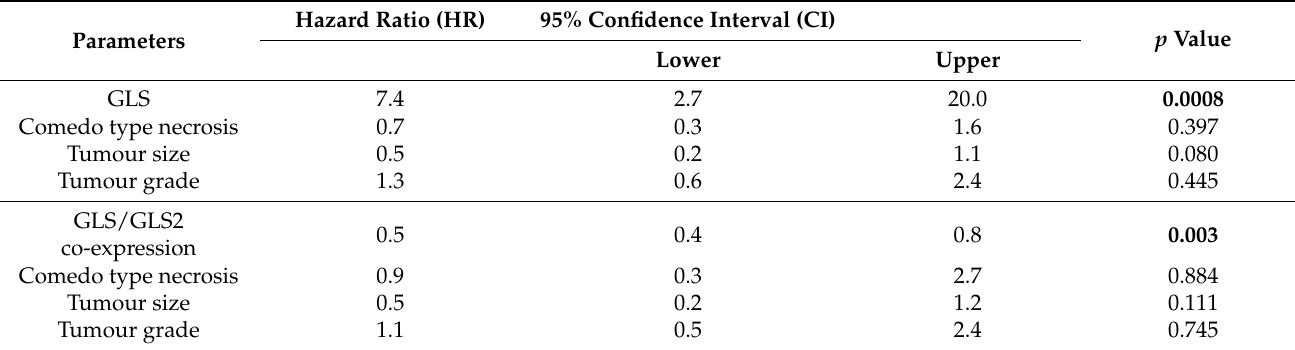
Table 5. Multivariate survival analysis of variables predicting LRFI for GLS and GLS/GLS2 protein co-expression in ER +/HER2- DCIS.